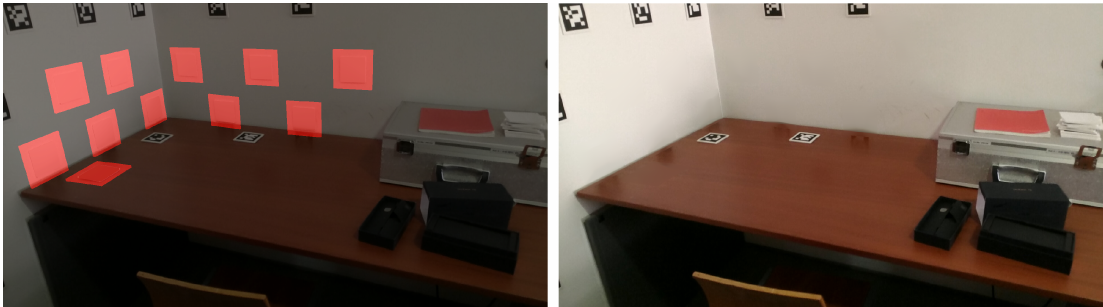
Figure 10. Example dataset image restoration improvement: ( left ) mask for the pixels to be replaced (based on enlarged 3D masks); ( right ) results with second blurring.